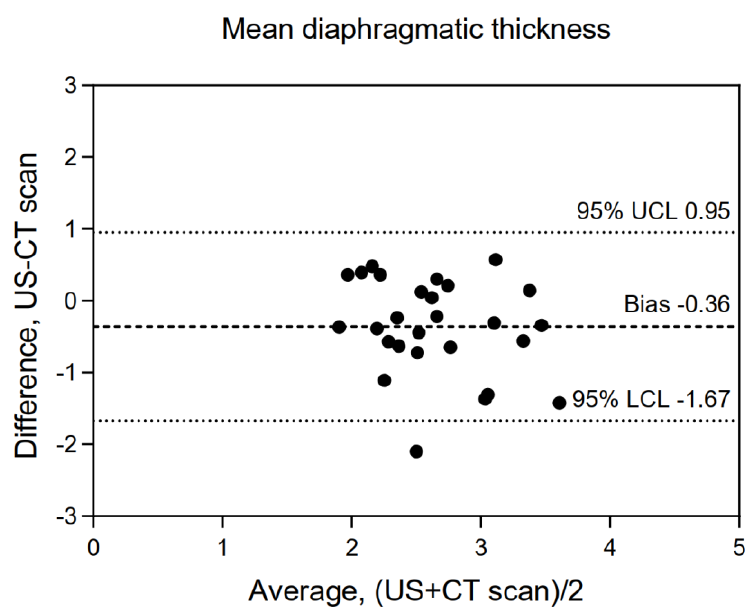
Figure 3. Bland–Altman plot exploring the agreement between the right hemidiaphragm thickness evaluated by US and the mean diaphragmatic thickness assessed by CT scan. Data are expressed in mm. UCL = upper confidence limit; LCL = lower confidence limit. Definition of abbreviation: US = ultrasound; CT scan = computerized tomographic scan.